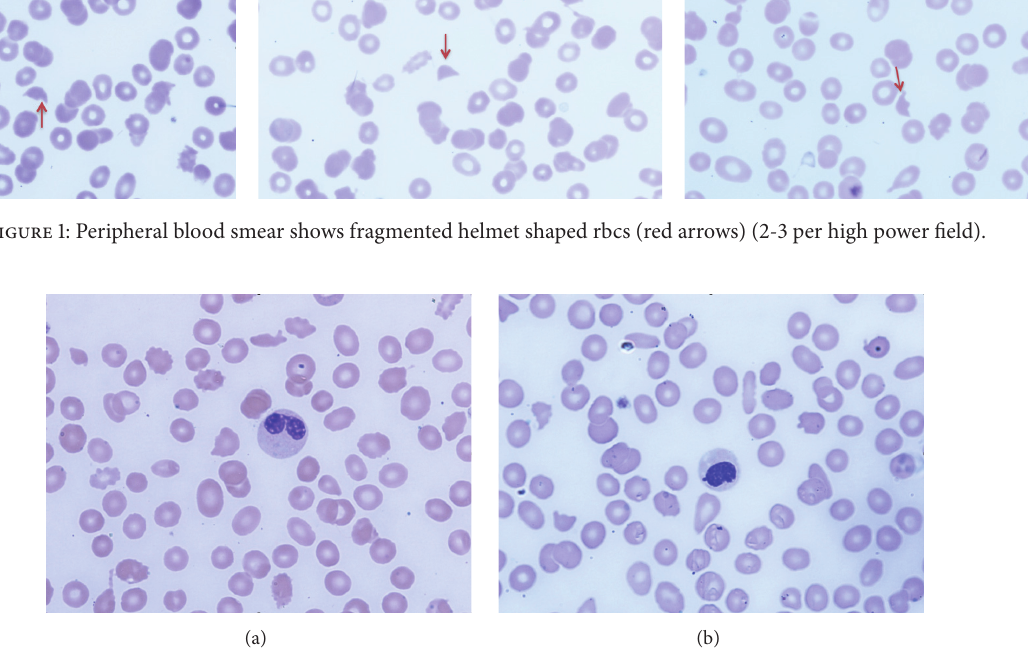
Figure 2: Peripheral blood smear (Wright Giemsa stain at 100x magnification) shows dysplastic neutrophils characterized by nuclear hypolobation (Pseudo-Pelger H¨uet) and decreased granules (a). Neutrophil with a nonlobated nucleus